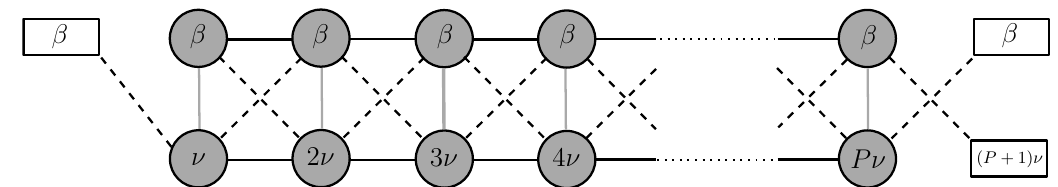
Figure 8 . The quiver encoding our fourth example. The conventions for the (cid:12)elds running along the di(cid:11)erent lines are the same as those in section